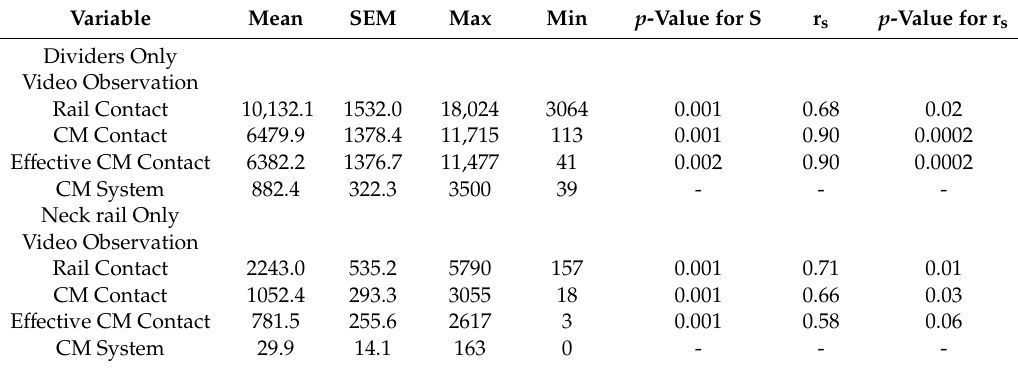
Table 1. Average total number of contacts made by each cow ( n = 11) over the 16 h observation period with the dividers or neck rail for the CM system versus video observation with p -values for the Wilcoxon Signed-Rank test, and Spearman’s correlation coe ffi cient (r s ) with p -values for analyzing the agreement between the CM system and video observation on the ranked position of each cow based on the average number of contacts per min with the dividers or neck